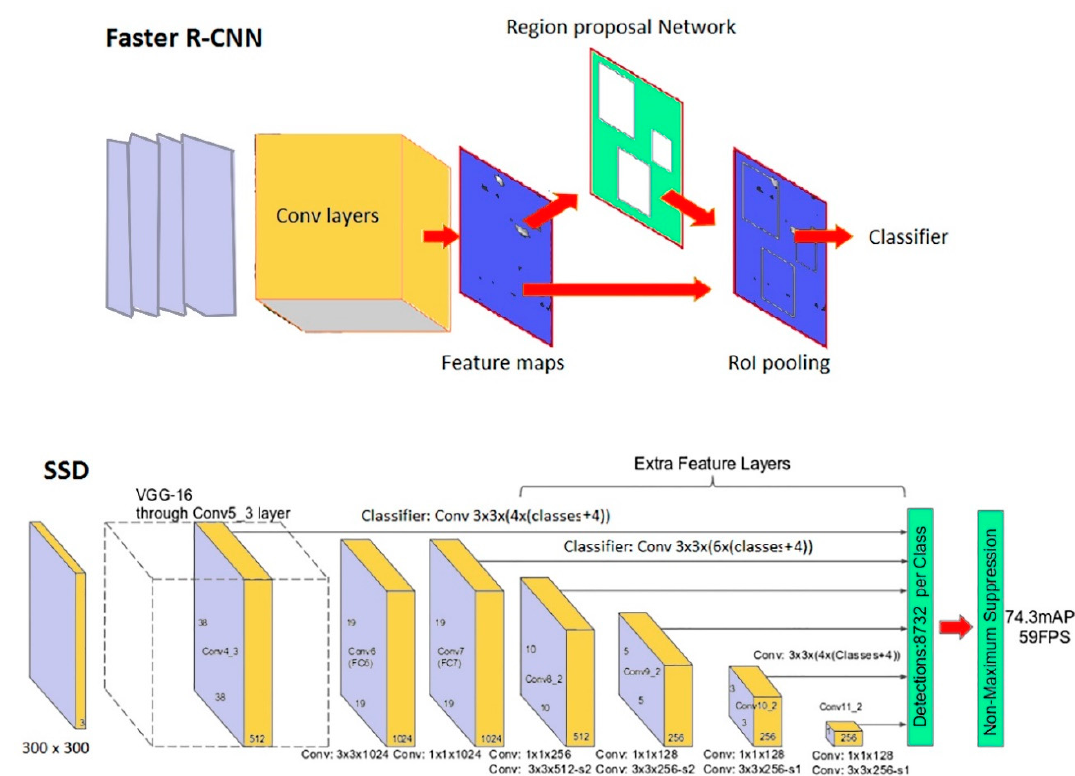
Figure 2. Sketch of the Faster Region-based Convolutional Neural Network (Faster R-CNN) and Single Shot Detector (SSD) network.